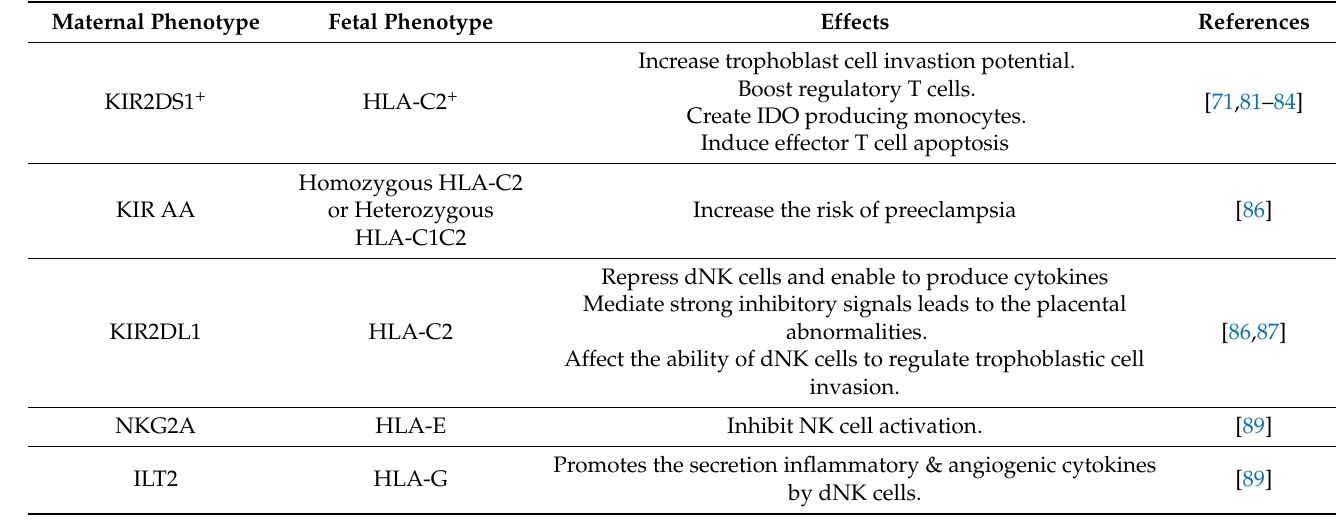
Table 1. Crosstalk at maternal-fetal interface by combination of KIR and HLA from mother and fetus, respectively, and